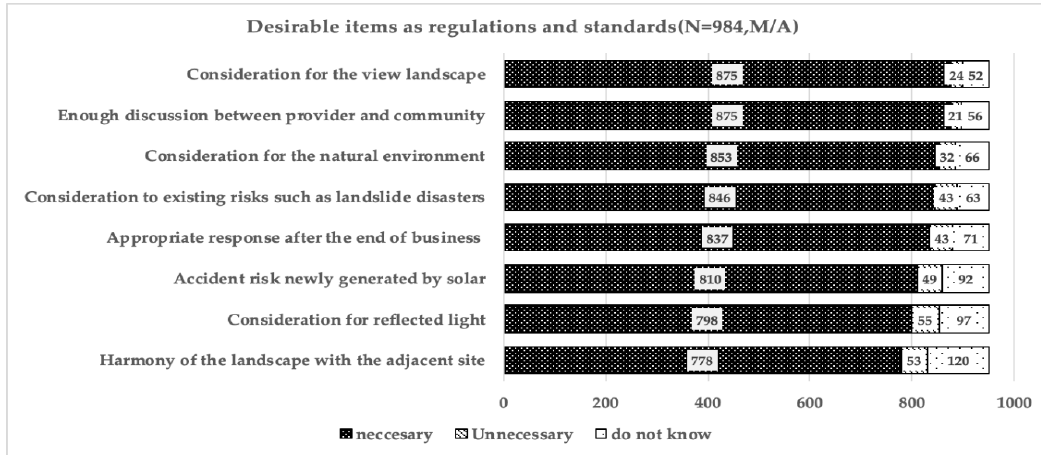
Figure 4. Items recognized by local governments to be regulated. Source: Own survey data.